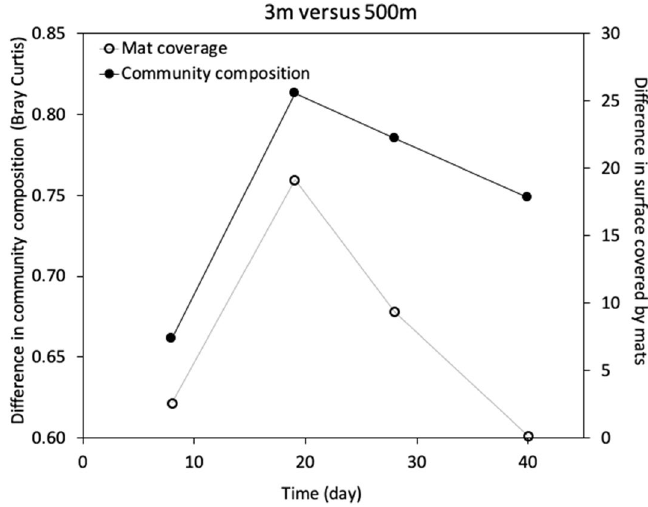
Figure 3. Difference in bacterial community composition based on Bray Curtis dissimilarity compared to the difference in mat coverage between 3 and 500 m depth inoculum experiments.